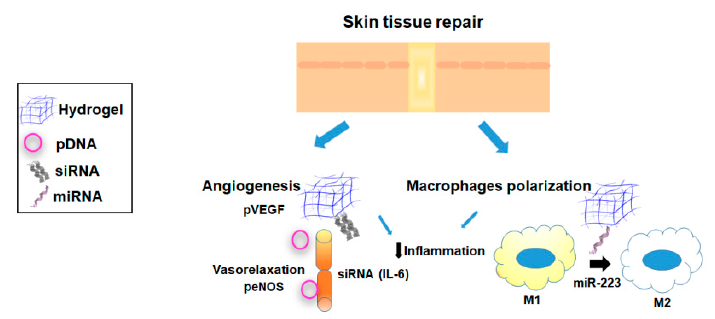
Figure 5. Main strategies involving the use of hydrogel-based nonviral gene delivery systems for skin tissue repair .